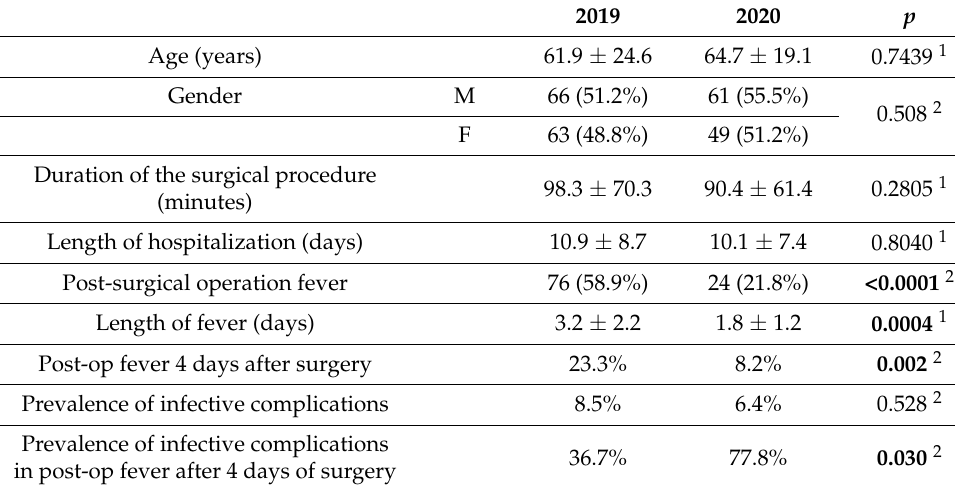
Table 1. Results table and comparison between the two groups.